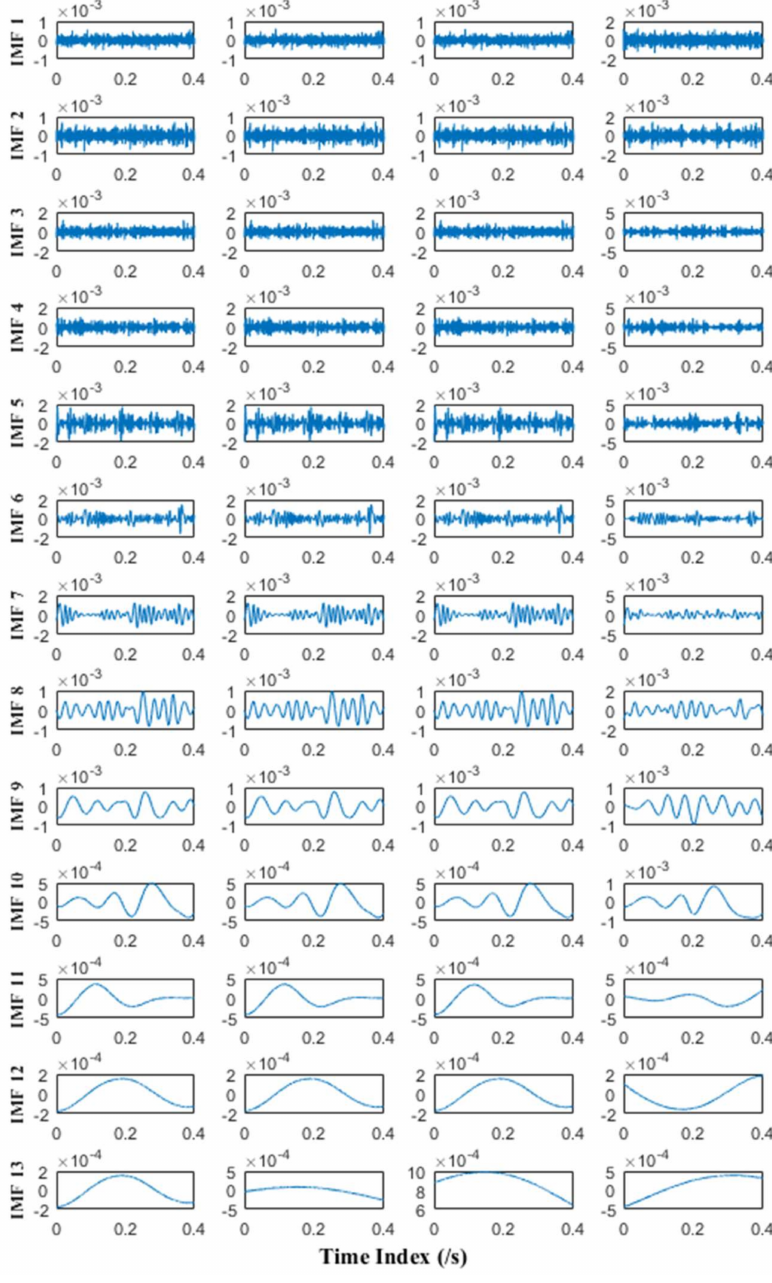
Figure 17. Time domain plots of IMFs of